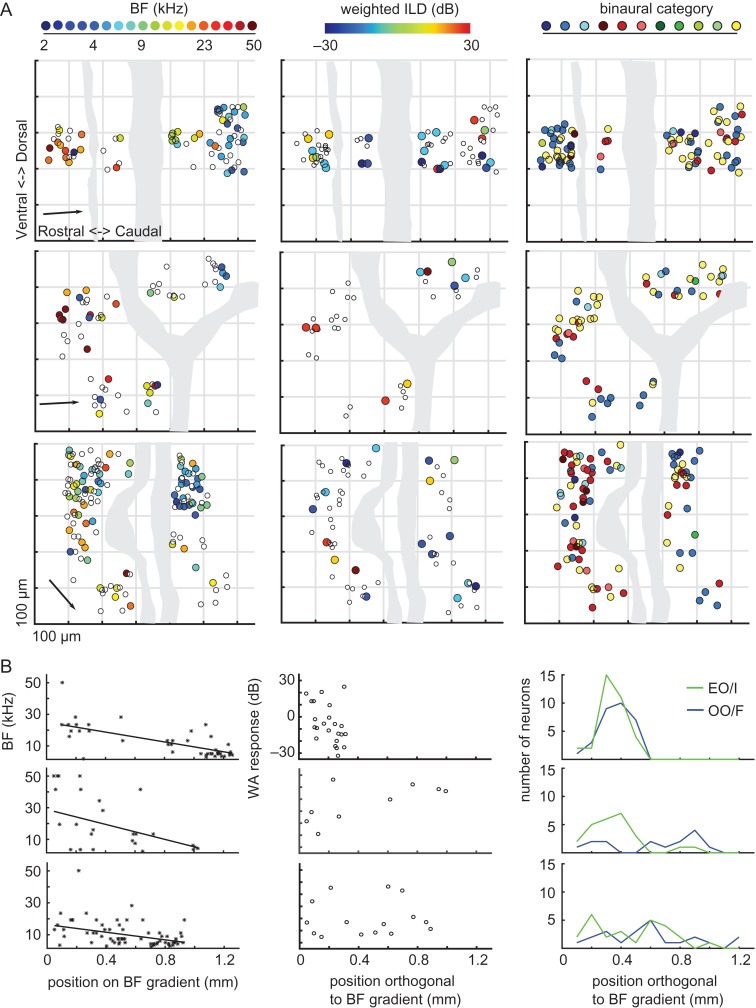
Sound frequency, but not binaural preferences, are topographically organized over large distances in A1. (A) Each plot shows the location of neurons along the rostro-caudal and dorso-ventral axes of the cortex. Data from a different transgenic mouse expressing GCaMP6f are plotted in each row, with neurons color-coded according to their BF (left column), weighted ILD preference (middle column), or binaural category (right column). Dotted grids indicate 200 × 200 μm. Gray shaded areas illustrate the position of blood vessels on the cortical surface. In the BF plots, the arrow indicates the orientation of the tonotopic gradient. (B) BFs plotted against distance along the tonotopic axis in each mouse, together with the corresponding line of best fit. (C) Weighted ILD preferences (WA, weighted average) plotted against distance along the axis orthogonal to the tonotopic gradient. (D) Number of EO/I and OO/F cells at different positions along the axis orthogonal to the tonotopic gradient.